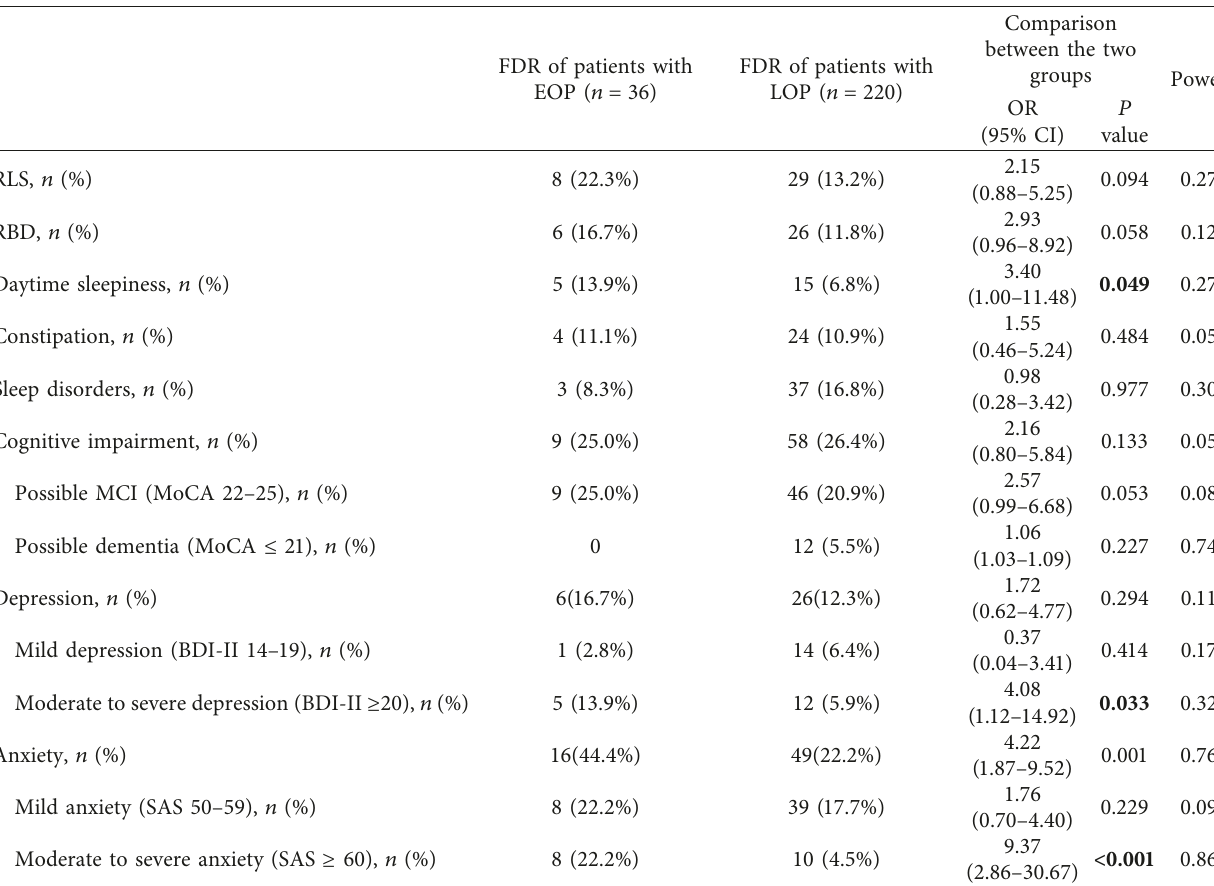
Table 2: Comparison of NMS between the FDR groups of EOP and